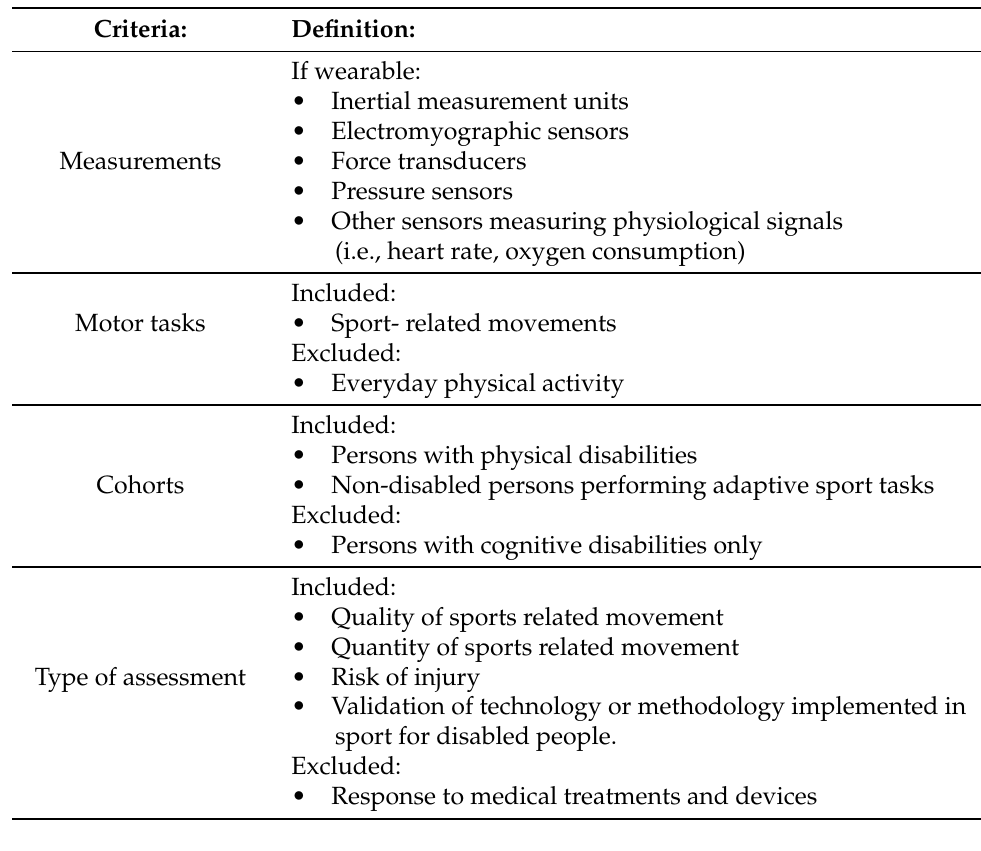
Table 1. Inclusion and exclusion